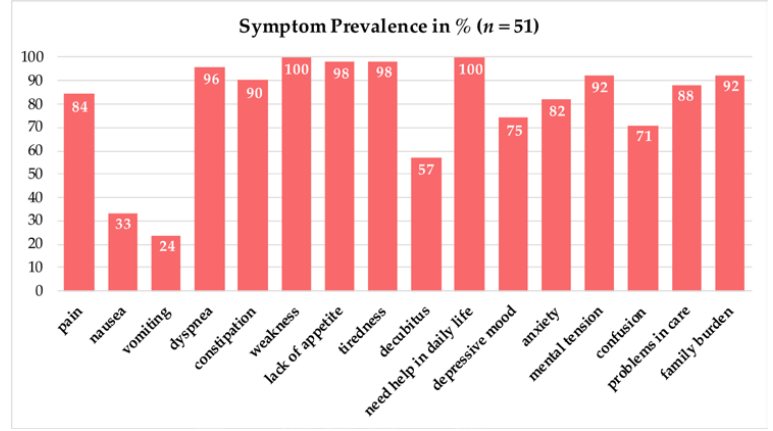
Figure 1. Symptom prevalence in percentage (%) assessed at the time of the first specialist palliative care contact.